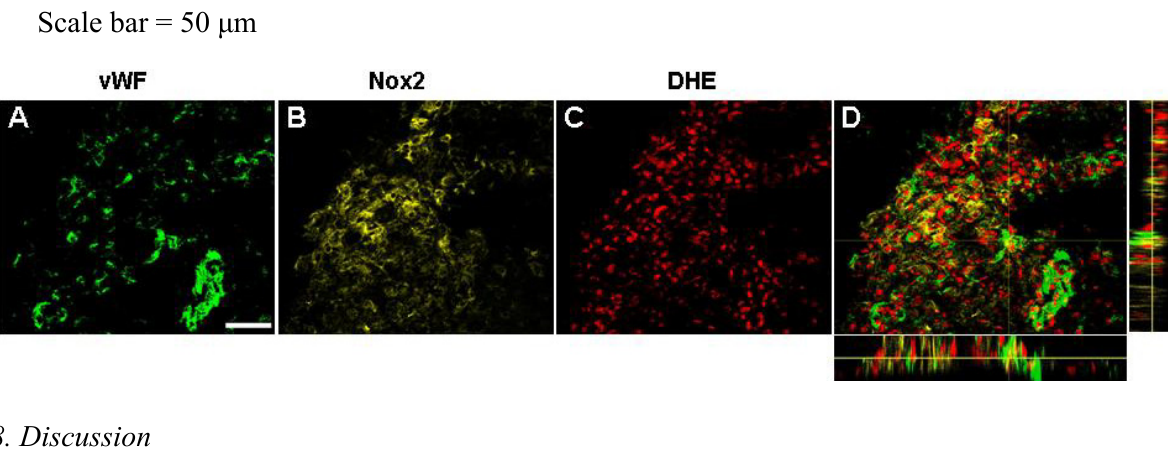
Figure 7. Newly formed blood vessels are positive for Nox2 and superoxide. Confocal microscopy of triple labelled immunofluorescence for vWF (green) ( A ), Nox2 (yellow) ( B ), and DHE (red) ( C ), in the damaged cortex shows new blood vessels are positive for both Nox2 and superoxide 7 days post stroke (Orthogonal view D ). Images were captured as collapsed reconstructions of optical sections every 0.2 μ m on the z